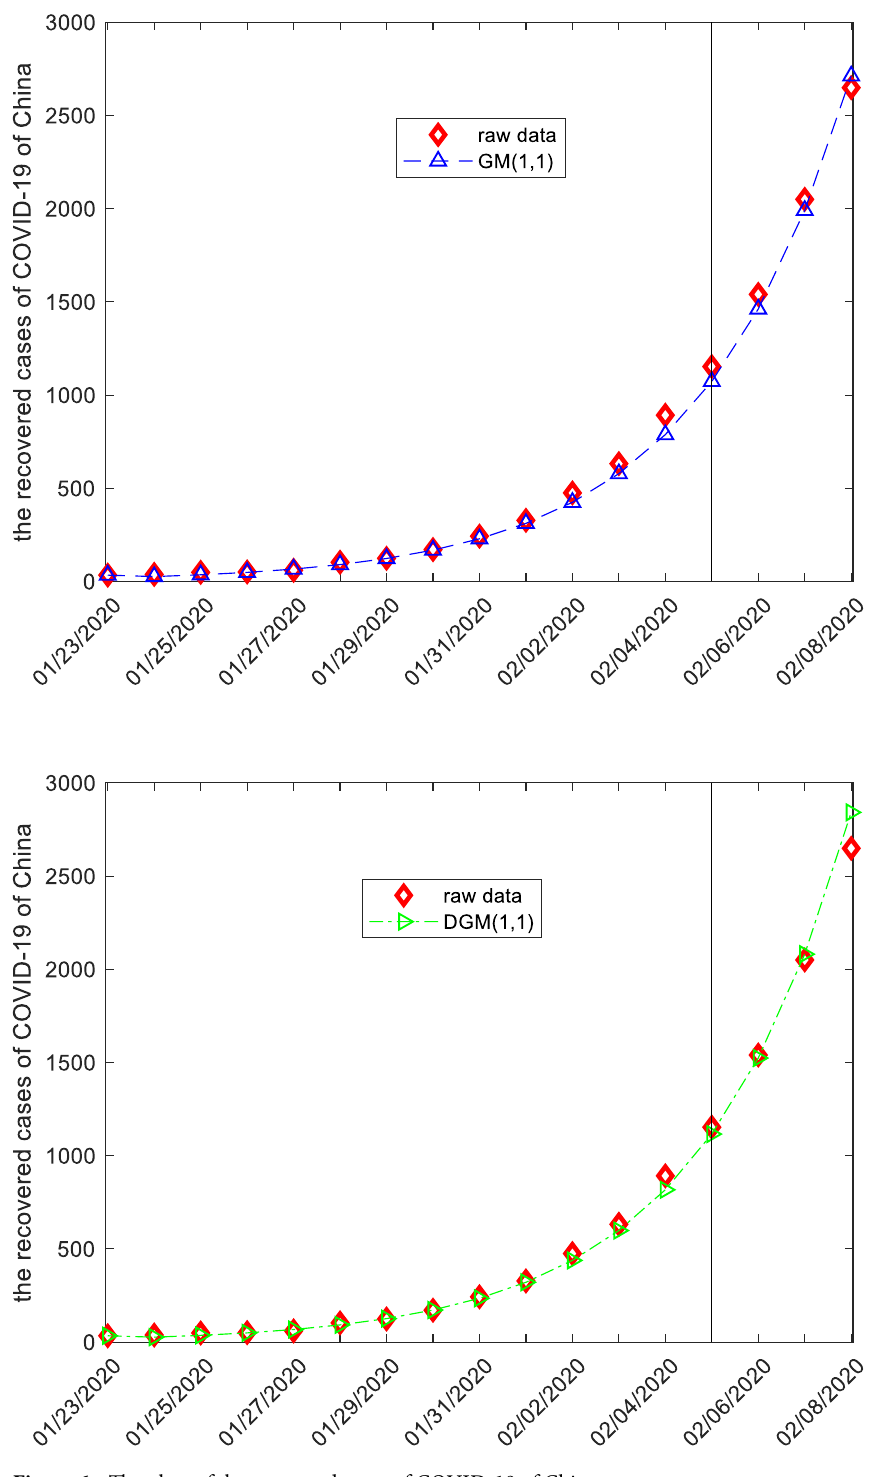
Figure 6. The plots of the recovered cases of COVID-19 of